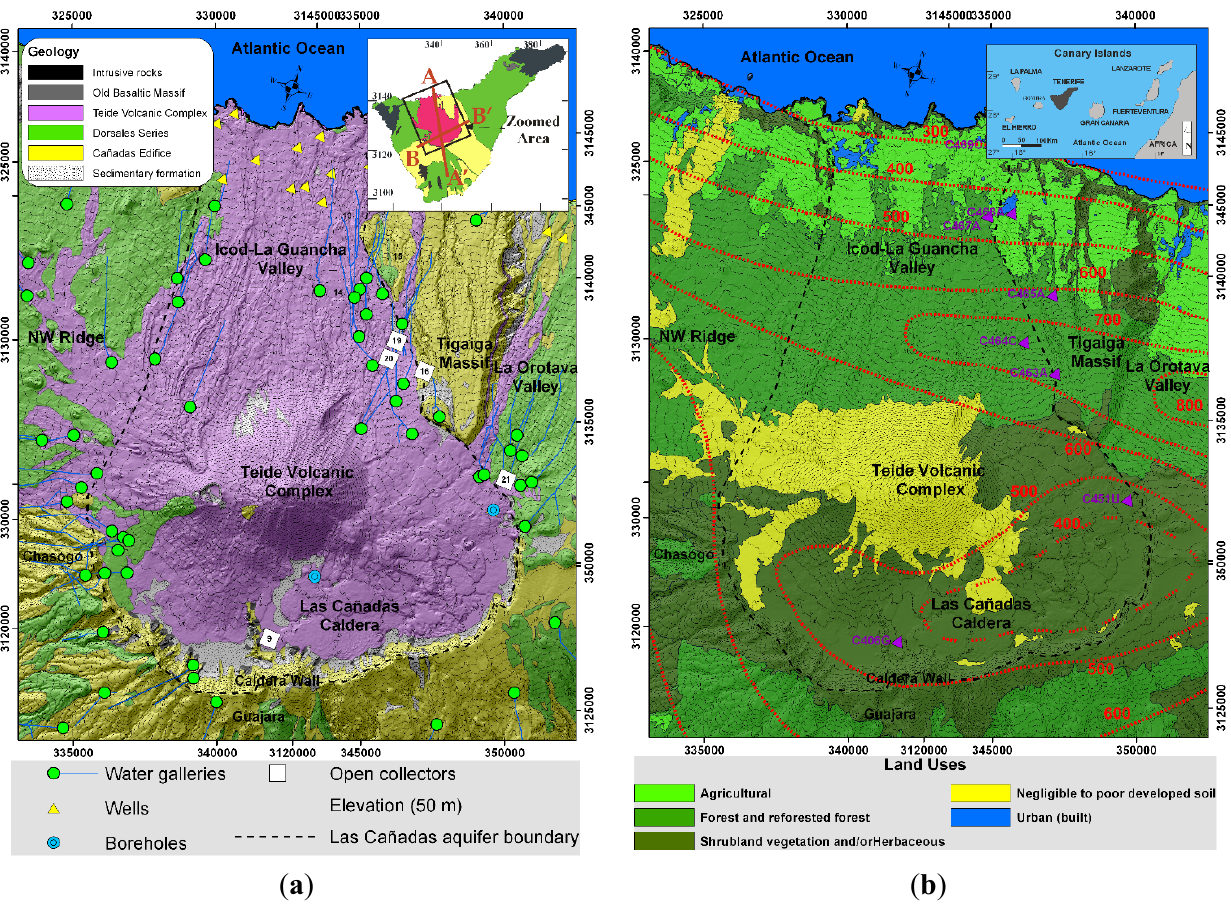
Figure 1. ( a ) Geological map of Las Cañadas aquifer system, showing the Teide Volcanic Complex materials partially filling both the Icod-La Guancha Valley and Las Cañadas Caldera; sites cited in the text, groundwater sampling points, and open collectors are included; ( b ) Land-use map of Las Cañadas aquifer system and mean annual precipitation contour map; weather stations (purple triangles) operated by the Spanish Agency for Meteorology (AEMET website: http://www.aemet.es/) are included. Data source: Insular Water Council of Tenerife (CIATFE) [27] and Cartographic Survey of Canary Islands